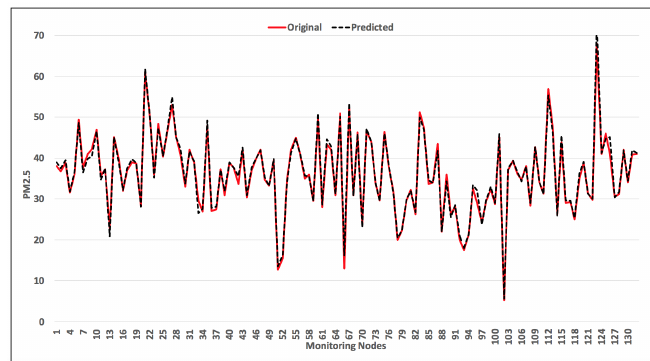
Figure 10. Comparison of observed and predicted PM2.5 values for 132 monitoring stations.